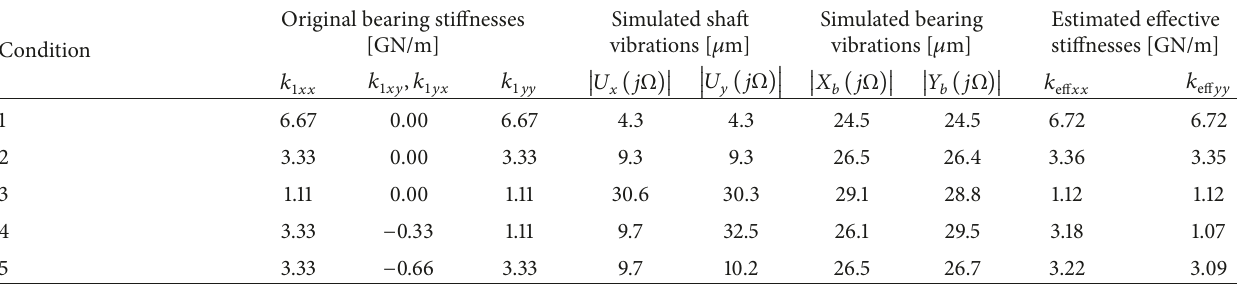
Table 4: Original and estimated bearing effective stiffnesses of the upper journal bearing ( k 2x = k 2y = 1.18GN/m) of a 700 MW hydrogenerator, using synthesized shaft and bearing vibration